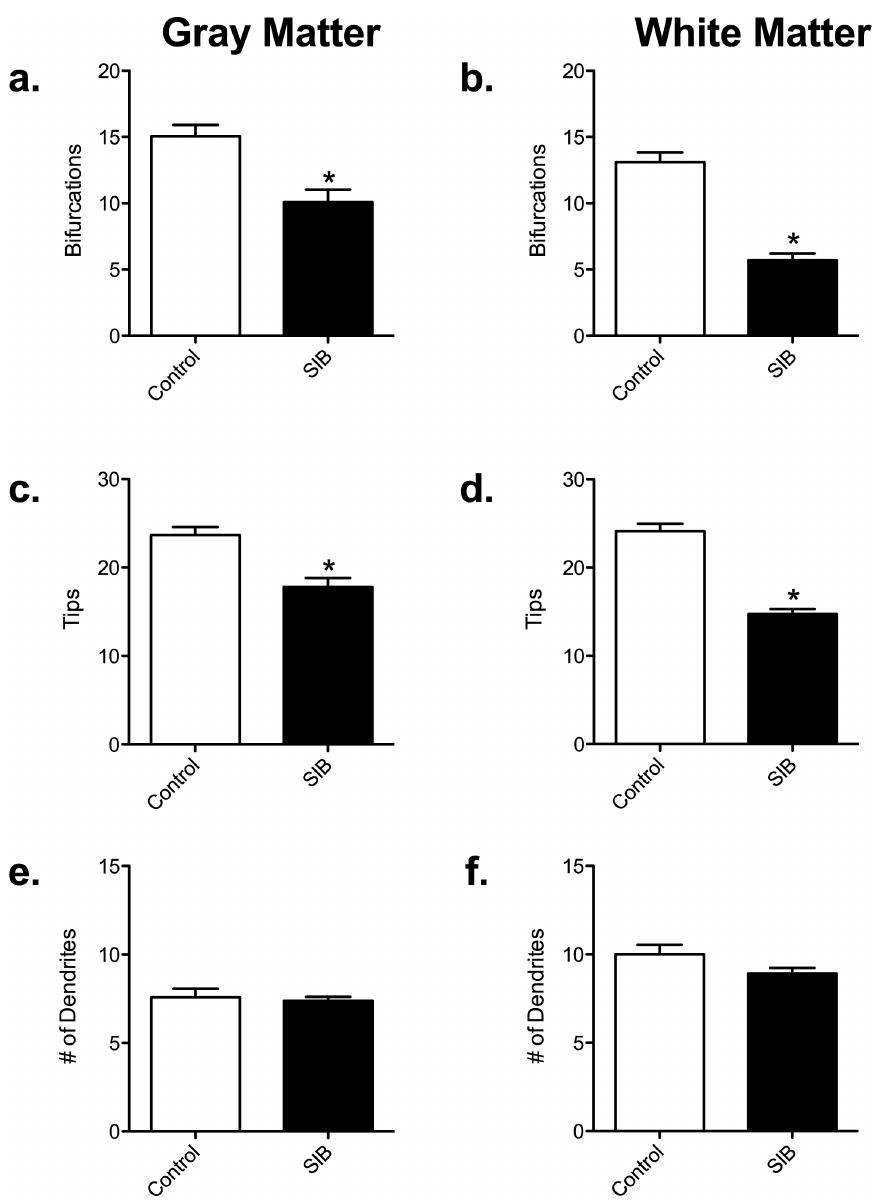
Figure 3. Astrocytes are less complex in self-injurious behavior. The number of bifurcations in the gray (a) and white (b) matter astrocytes was significantly decreased in the frontal cortex of macaques that had exhibited SIB. This correlated with a decreased number of tips, again in both gray (c) and white (d) matter. However, there was no alteration in the number of dendrites in either gray (e) or white (f) matter.